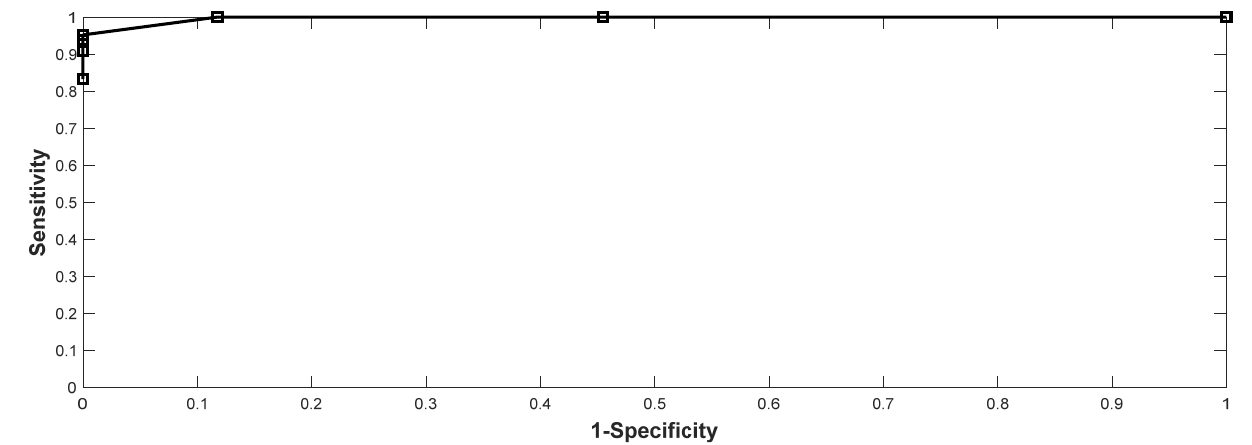
Figure 6. The results of ROC analysis on the performance of the SVM classifier.